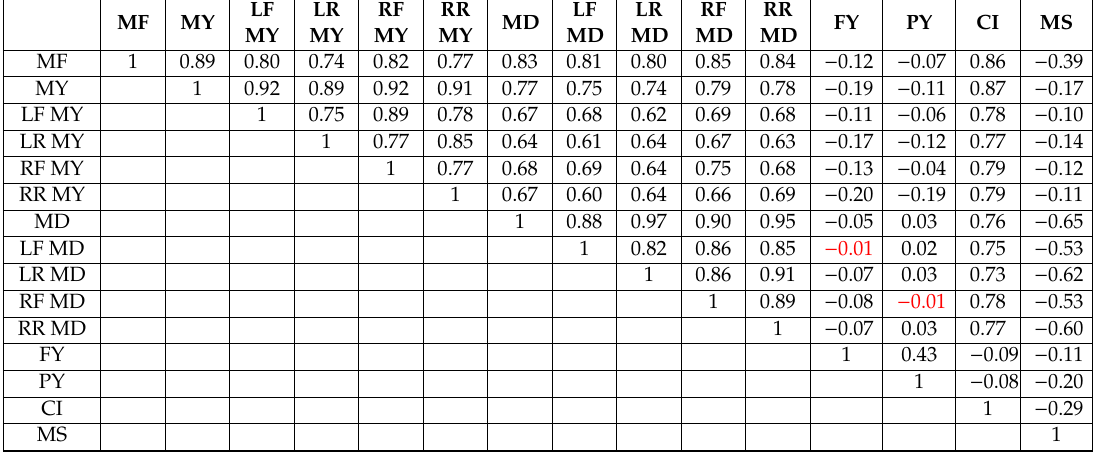
Table 10. Pearson’s correlation coe ffi cients of considered traits for daily